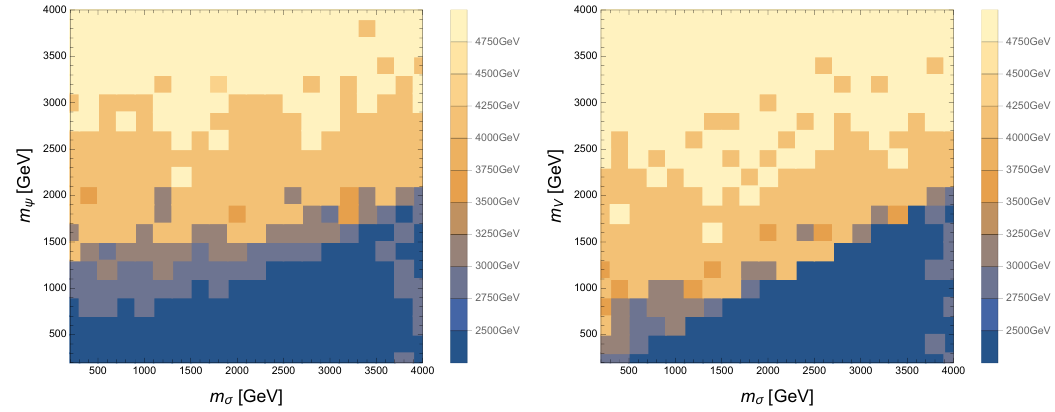
Figure 9 . Missing energy selection thresholds as a function of the dilaton and fermionic (left panel) and vector (right panel) dark matter masses to achieve the best sensitivity at a future 100 TeV proton-proton collider. In order to avoid any potential unitarity issues at high energies, we impose that the threshold value is smaller than 5